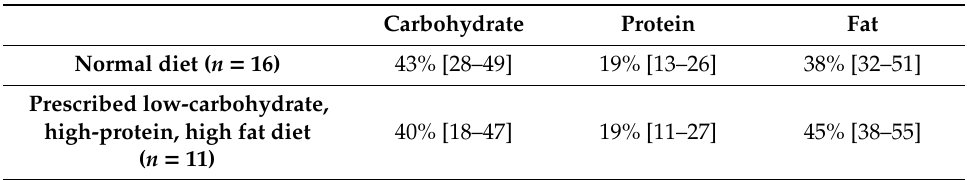
Table 7. Median percentage of energy contribution from carbohydrate, protein and fat of patients on prescribed compared to no ‘formal’ diet